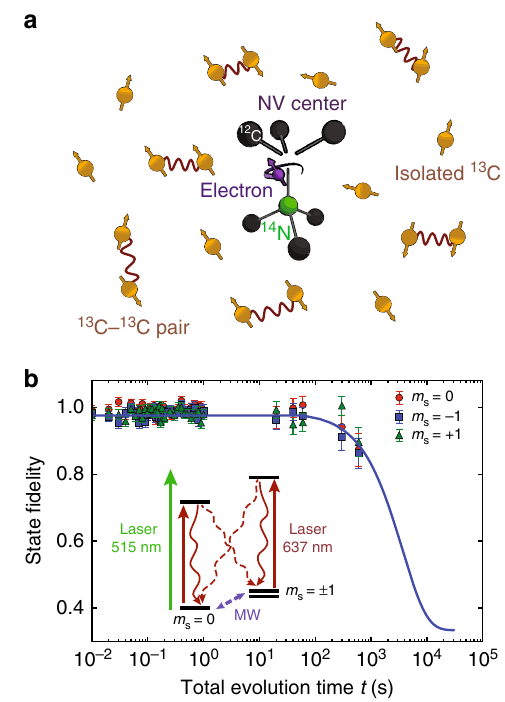
Fig. 1 Experimental system and T 1 measurements. a We study a single nitrogen-vacancy (NV) center in diamond surrounded by a bath of 13 C nuclear spins (1.1% abundance). In this work, we show that the microscopic nuclear-spin environment is accurately described by 7 isolated 13 C spins, 6 pairs of coupled 13 C spins and a background bath of 13 C spins (not depicted). b Longitudinal relaxation of the NV electron spin. The spin is prepared in m s ¼ 0 ; (cid:2) 1, or + 1 and the fi delity with the initial state is measured after time t . The inset shows the microwave (MW) and laser controls for the NV spin and charge states, as well as the pathways for spin relaxation induced by potential background noise from these controls. All error bars are one statistical